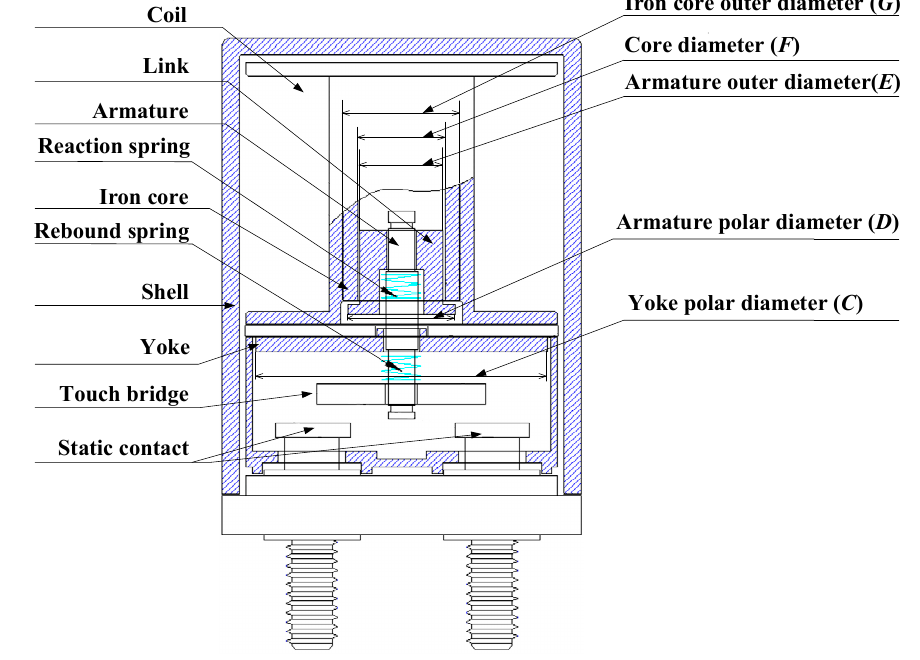
Figure 4. Structure of high-power DC contactor.